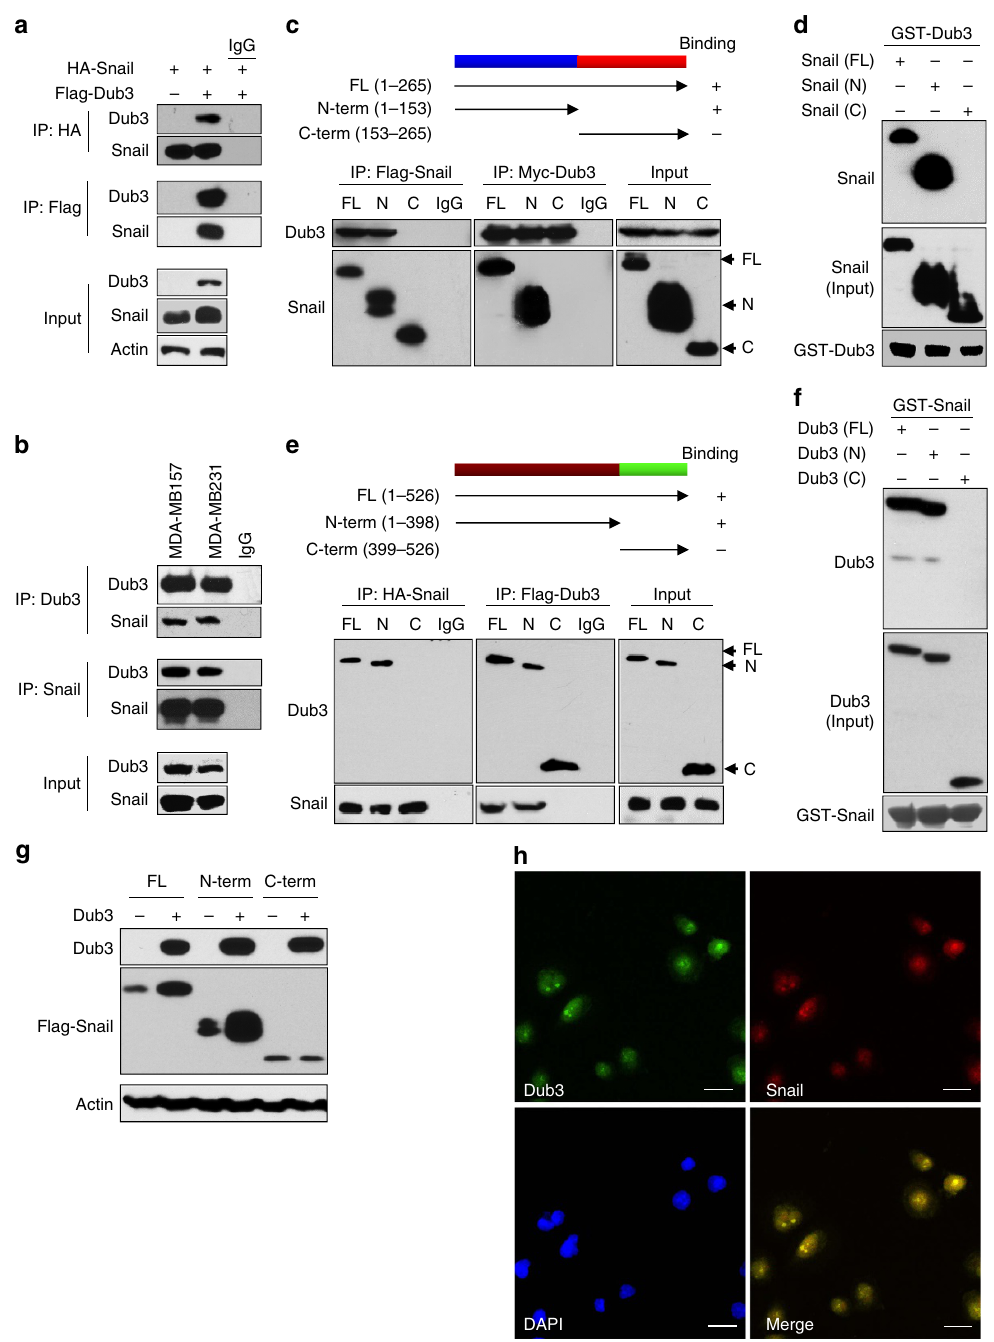
Figure 2 | Dub3 interacts with Snail1. ( a ) HA-Snail1 was co-expressed with vector or Flag-Dub3 in HEK293 cells. Snail1 and Dub3 were immunoprecipitated (IP) with HA or Flag antibody, respectively, and the associated Dub3 and Snail1 were analysed by western blot using either Flag or HA antibody. One-fortieth of the lysate from each sample was subjected to western blot to examine the expression of Snail1 and Dub3 (input lysate). ( b ) Endogenous Snail1 and Dub3 were captured by IP from MDA-MB231 and MDA-MB157 cells, and the bound endogenous Dub3 and Snail1 were examined by western blot. ( c ) Schematic diagram showing the structure of Snail1 and deletion constructs used (top panel). Flag-tagged full-length (FL) or deletion mutants of Snail1 were co-expressed with Myc-Dub3 in HEK293 cells. Extracts were subjected to IP with Flag or Myc antibody, and bound Dub3 or Snail1 was analysed by Western blot using either Myc or Flag antibody. ( d ) Lysates from HEK293 cells expressing WT or different deletion mutants of Flag-Snail1 were mixed with GST-Dub3. After pull-down by glutathione-agarose, the associated proteins were analysed by western blot. ( e ) Schematic diagram showing the structure of Dub3 and deletion constructs used (top panel). Myc-tagged full-length or deletion mutants of Dub3 were co-expressed HA-Snail1 in HEK293 cells. Extracts were subjected to IP with Myc or HA antibody, and the bound Snail1 or Dub3 was analysed by western blot using either HA or Myc antibody. ( f ) Lysates from HEK293 cells expressing WTor different deletion mutants of Myc-Dub3 were mixed with GST-Snail1. After pull-down by glutathione-agarose, the associated proteins were analysed by western blot. ( g ) Myc-Dub3 was co-expressed with Flag-tagged full-length or deletion mutants of Snail1 in HEK293 cells. The protein expressions of Dub3 and Snail1 were analysed by western blot. ( h ) Endogenous Dub3 and Snail1 in MDA-MB231 cells was detected by IF staining. Scale bars, 20 m